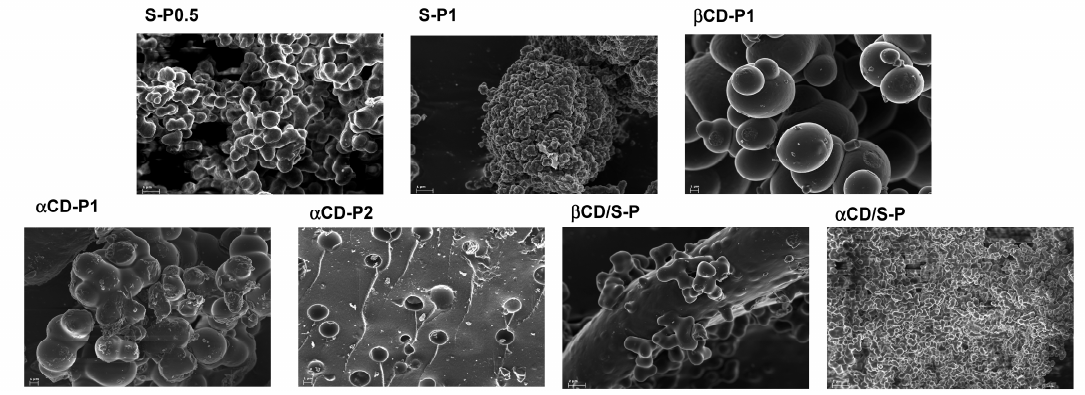
Figure 1. Electron microscopy study: Micrographs taken at 20,000× ( S-P0.5 , S-P1 and α CD/S-P ) and 10,000× ( β CD-P1 , α CD-P1 , α CD-P2 and β CD/S-P )